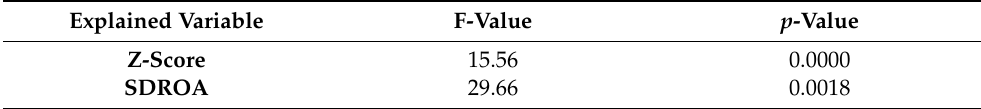
Table A6. Wald test (Fintech